Question: What does this figure show? Answer in one sentence.
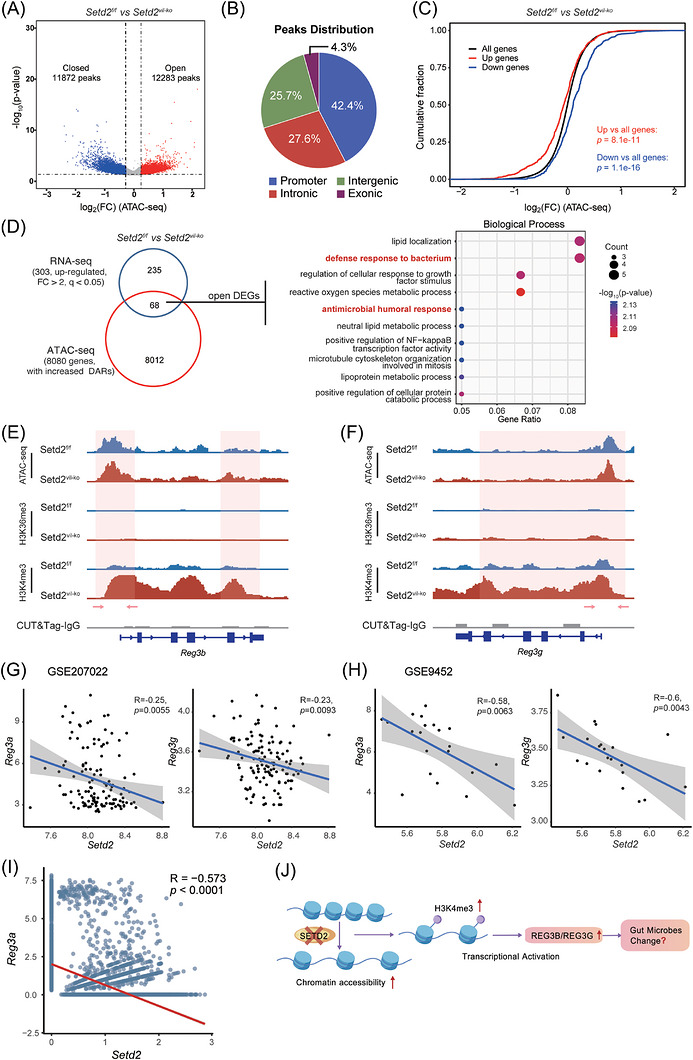
Answer: REG3 upregulation induced by SET domain containing 2 (SETD2) deficiency involves enhanced chromatin accessibility and H3K4me3 activation. (A) Volcano plots of assay for transposase‐accessible chromatin with high‐throughput sequencing (ATAC‐seq) differential peaks. The number of peaks with significant changes ( p < .05 and |log 2 FC| > .263) upon Setd2 deletion is shown. (B) Pie chart illustrating the proportion of differentially accessible ATAC‐seq peaks located in promoter, intronic, intergenic and exonic regions. (C) Cumulative distribution of chromatin accessibility changes associated with significantly upregulated (red) or downregulated (blue) genes ( q < .05 and |log 2 FC| > 1) in Setd2 vil‐ko mice compared with Setd2 f/f controls. p ‐Values were calculated using a two‐sided Kolmogorov‒Smirnov test comparing peaks associated with differentially expressed genes (DEGs) to all genes. (D) Integrated analysis of upregulated DEGs from RNA sequencing (RNA‐seq) and genes with increased differentially accessible regions (DARs) from ATAC‐seq, termed as open DEGs (left). Gene Ontology (GO) analysis of the 68 open DEGs identified antimicrobial‐related biological processes (right). (E and F) Representative ATAC‐seq signals, H3K36me3 and H3K4me3 signals (cleavage under targets and tagmentation sequencing [CUT&Tag‐seq]) at the Reg3b (E) and Reg3g (F) gene loci in intestinal epithelial cells (IECs) from DSS‐treated (5 days) Setd2 f/f and Setd2 vil‐ko mice. Pink, differentially accessible regions. Arrows indicate signals in promotor regions. (G and H) Scatter plot showing the correlation between expression levels of Setd2 , Reg3a and Reg3g in inflamed Crohn's disease (CD) (G) and ulcerative colitis (UC) colon (H) from Gene Expression Omnibus (GEO) microarray datasets GSE207022 and GSE9452 . Pearson's R ‐value and p ‐value for the correlation coefficient are shown on the upper right side. (I) Correlation analysis of the expression levels of Setd2 and Reg3a in IECs from our forme